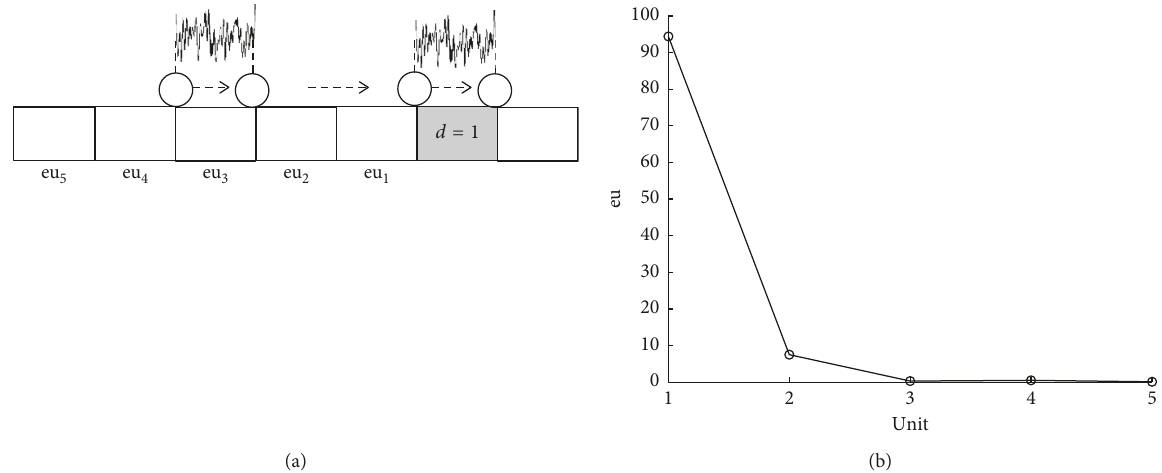
Figure 5: Boundary effects analysis: (a) diagram of effect index; (b) effect index ( l � 0.65m and d �